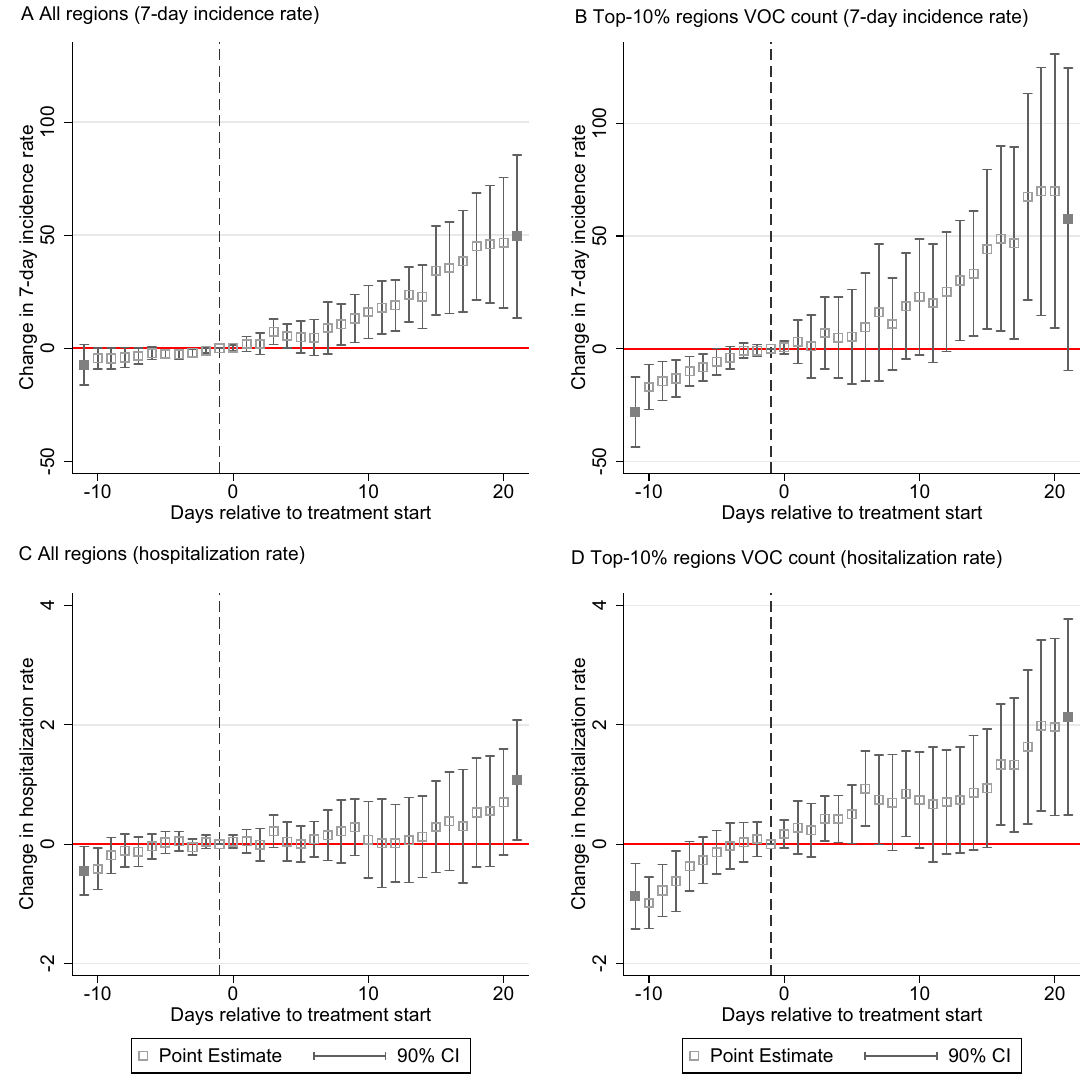
Figure 3. Panel event study estimates for trend development in the 7-day incidence rate (Panel A and B) and the hospitalization rate (Panel C and D) in regions with confirmed VOC cases around the day of first VOC reporting. Hollow squares show estimated daily point estimates; grey squares report cumulative estimates beyond the maximum number of leads (10) and lags (20) around the start of the first VOC reporting in treated regions. The dashed vertical line indicates that the last day before treatment start (− 1) serves as benchmark period for the estimated daily lead and lag